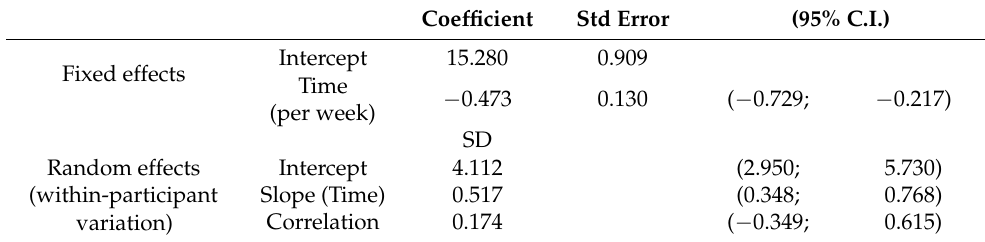
Table 4. Estimates from a longitudinal mixed-effects model of depression self-ratings (QIDS-A17-SR). Coefficient Std Error (95%